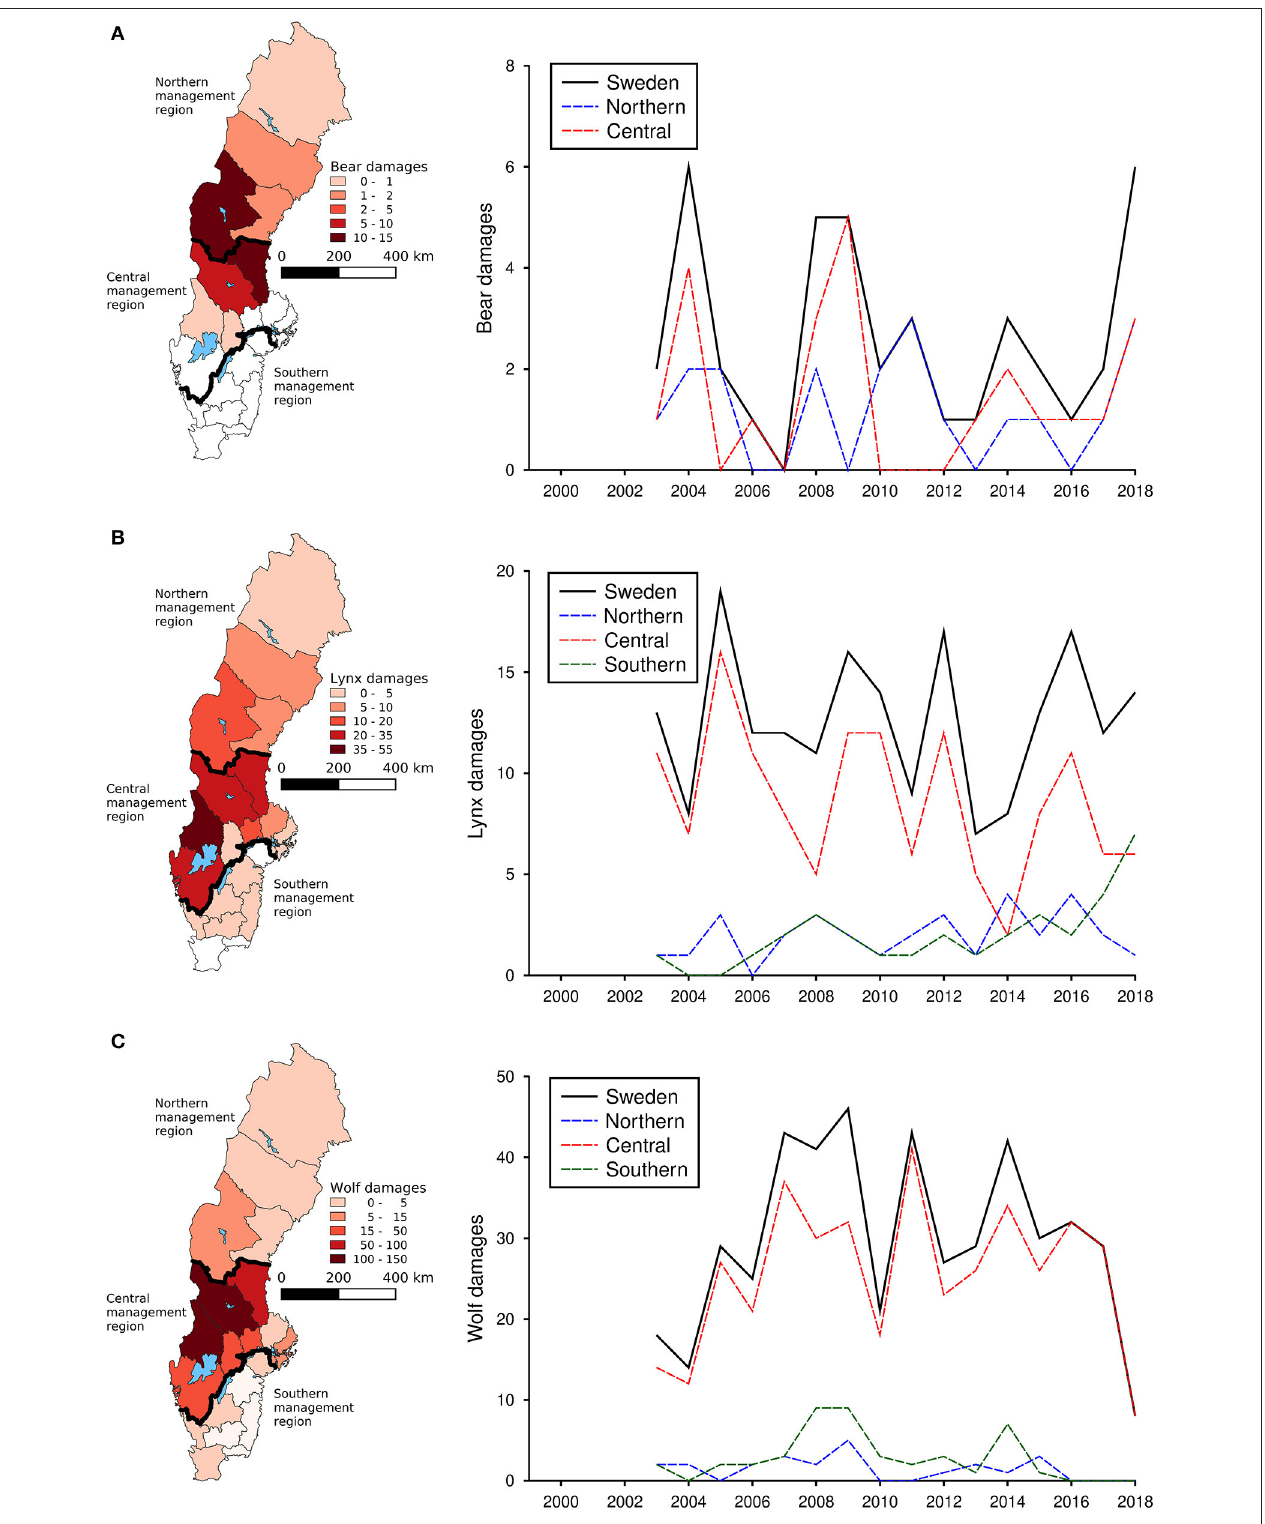
FIGURE 4 | Total number of damaged domestic dogs by brown bear (A) , Eurasian lynx (B) , and gray wolf (C) in each county of Sweden from 1999 to 2018 as well as the national and regional trends for the same time period.